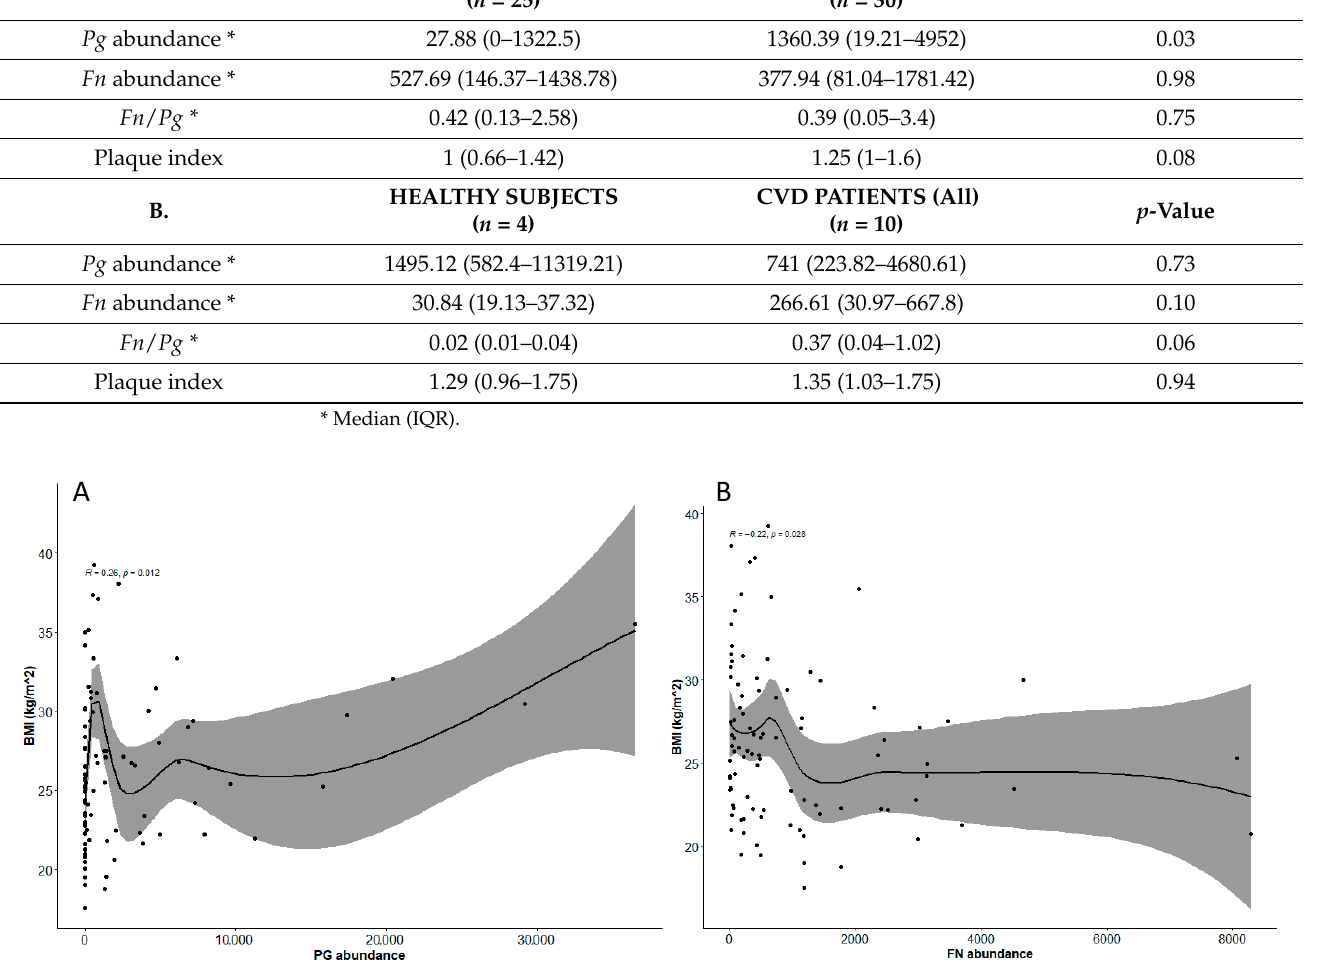
Figure 1. Correlation between BMI and Pg abundance (panel A ) and Fn abundance (panel B ) in the whole study cohort.